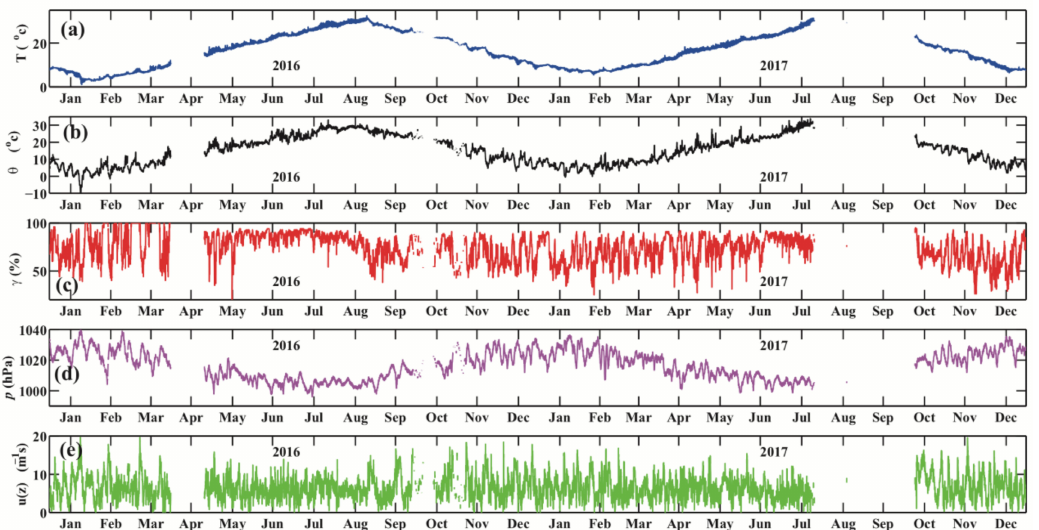
Figure 3. Time series of the air-sea variables observed at the platform from 2016 to 2017. The hourly SST (dark blue), SAT (black), RH (red), SLP (purple) and WS (green) are shown in panels ( a – e ),